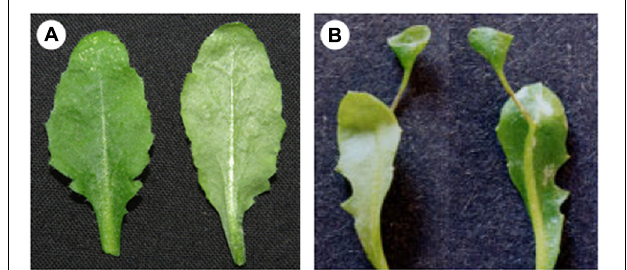
FIGURE 2 | Leaf phenotypes of wild-type and mutant Arabidopsis plants. (A) Flat-shaped leaves of wild-type Arabidopsis plant. (B) Trumpet-shaped leaves of rev gain-of-function mutant Arabidopsis plant. Note the resemblance of the mutant leaf with those of Nepenthes (inset in Figure 1D ). Images on the left and right of (A,B) correspond to the adaxial and abaxial sides, respectively. (B) Is reproduced from Zhong and Ye (2004) with permission from Oxford University Press, United